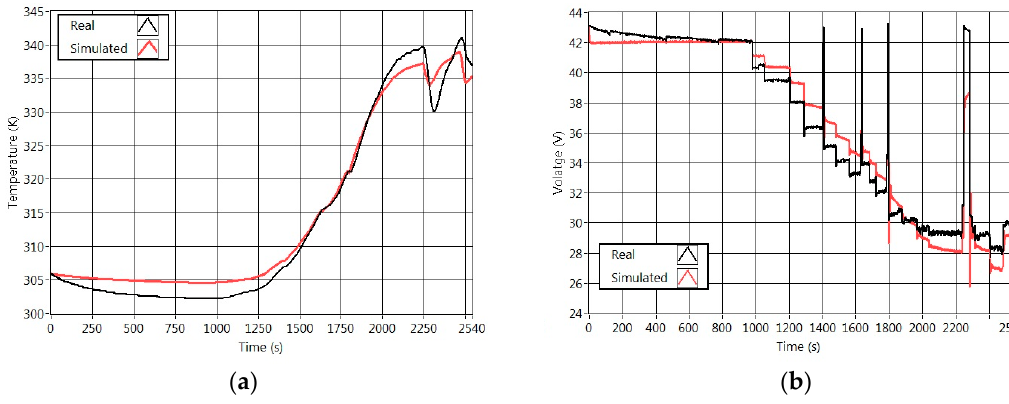
Figure 9. Simulation with the identified parameters using the second current profile. ( a ) Stack temperature; ( b ) output voltage.